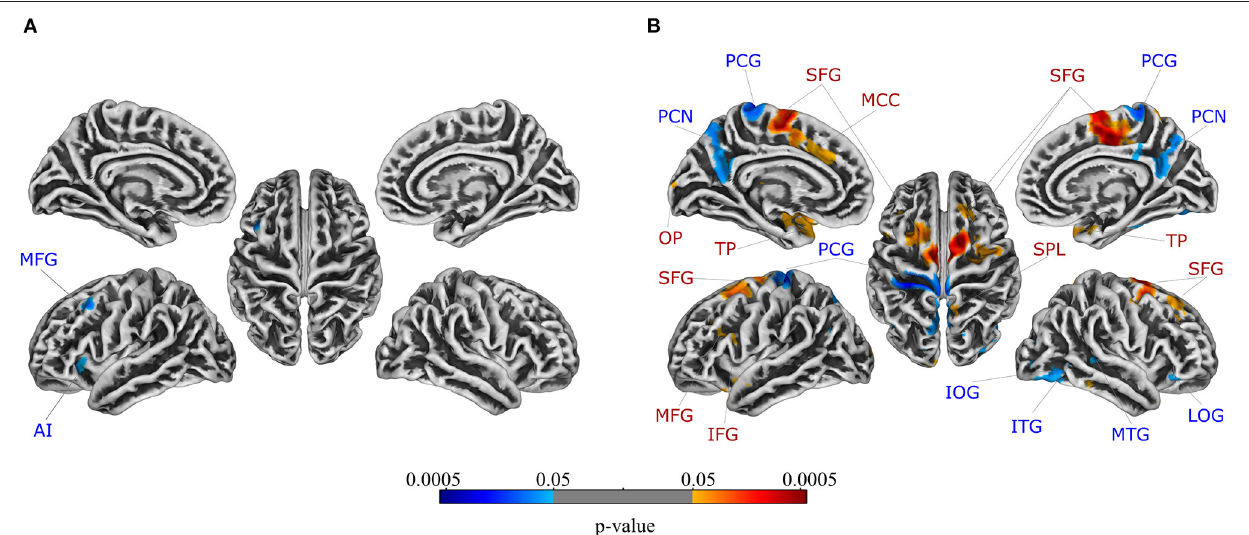
FIGURE 1 | Regions in which gray matter volume was lower in patients compared to healthy controls are depicted in blue, while regions in which gray matter volume was higher in patients compared to healthy controls are shown in red for patients with (A) ulcerative colitis and (B) irritable bowel syndrome. FWE-correction was applied at the significance level of p < 0.05. Axial slices are provided in Supplementary Figures 1, 3 , respectively. For details, see Table 2 . AI, anterior insula; IFG, inferior frontal gyrus; IOG, inferior occipital gyrus; ITG, inferior temporal gyrus; LOG, lateral orbital gyrus; MCC, middle cingulate gyrus; MFG, middle frontal gyrus; MTG, middle temporal gyrus; OP, occipital pole; PCG, postcentral gyrus; PCN, precuneus; SFG, superior frontal gyrus; SPL, superior parietal lobule; TP, temporal